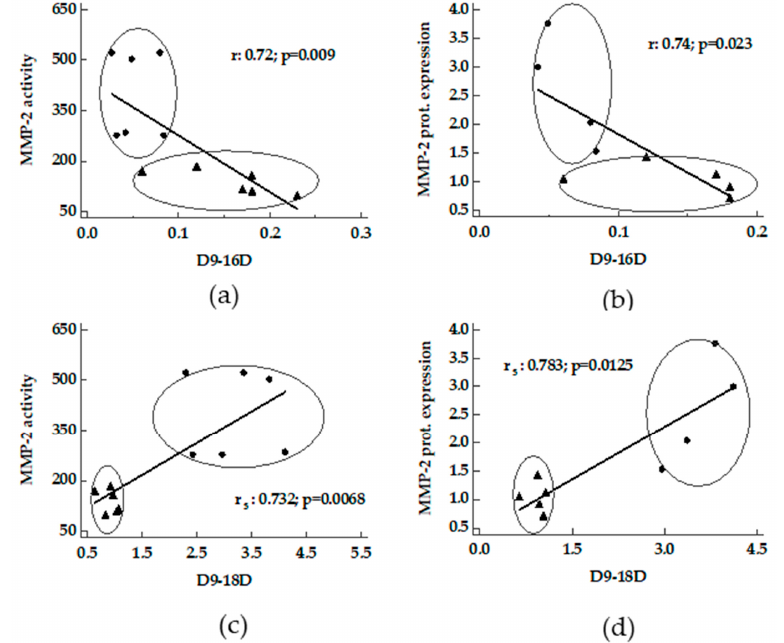
Figure 5. Correlation between desaturases and MMPs in livers from MCD and Obese Zucker rats. Panels a and b , D9-16D activity index versus MMP-2 activity and MMP-2 protein expression; panels c and d , D9-18D activity index versus MMP-2 activity and MMP-2 protein expression. • : MCD rats; (cid:78) : Obese Zucker rats.